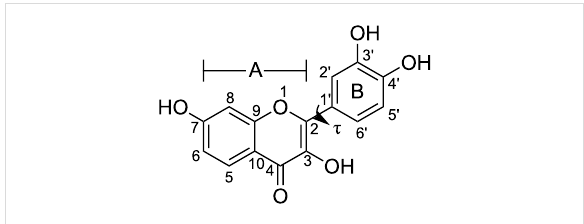
Figure 1: Chemical structure of fisetin with the definition of the A- and B-rings (chromone and phenyl subunits). The atomic labels and the torsional angle ( τ ) between both aromatic rings are given.